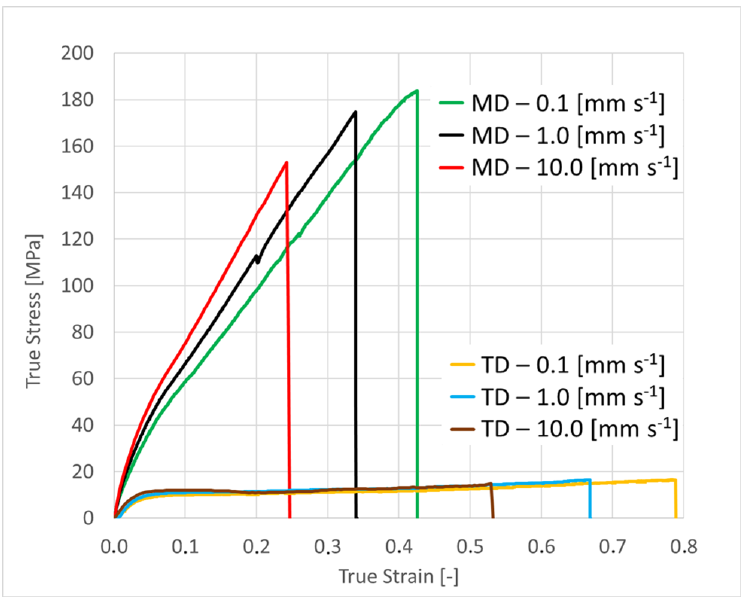
Figure 6. Tested true stress vs. true strain curves at two orientations (machine direction (MD) and transverse direction (TD)) and three different tension velocities.